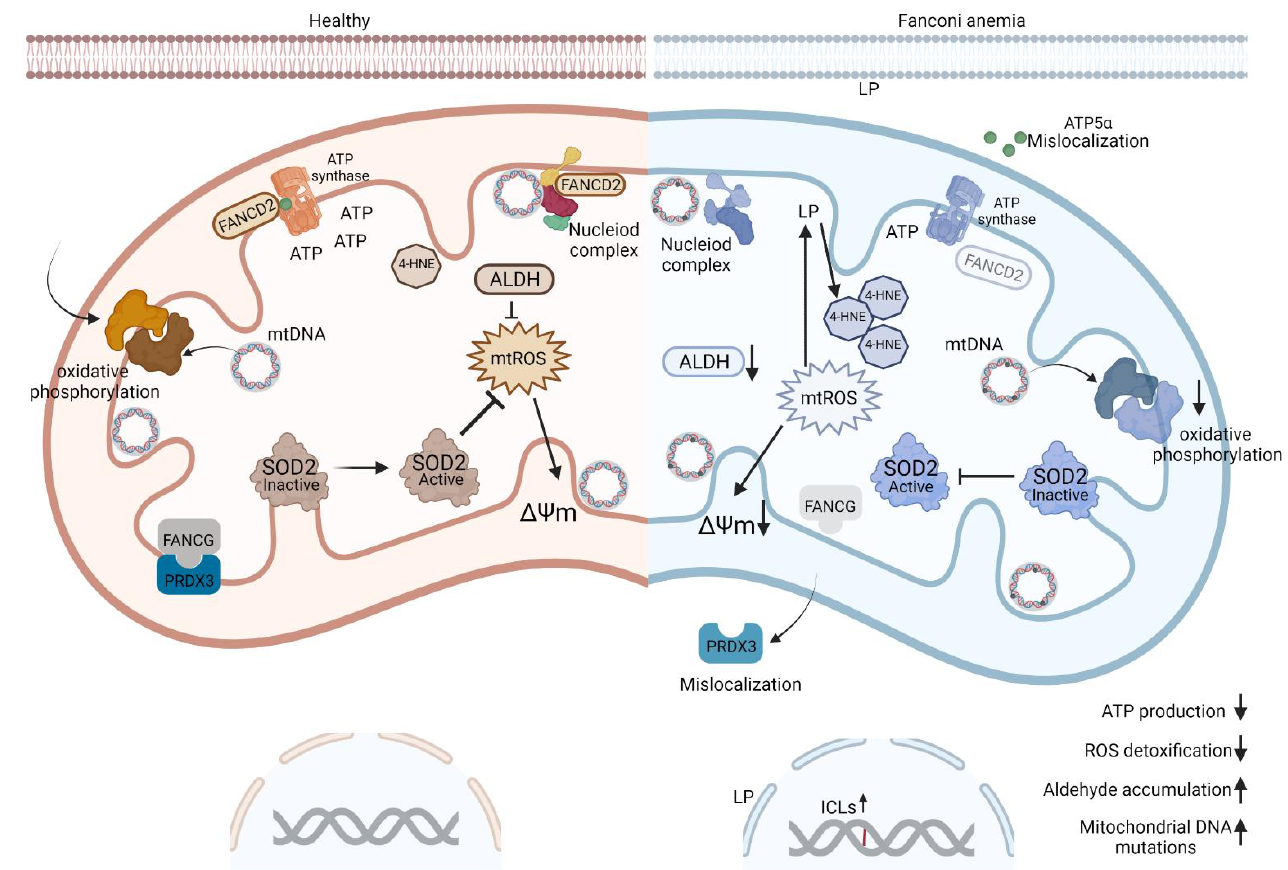
Figure 2. Schematic of Fanconi Anemia (FA) protein function in healthy (brown, left) versus FA- deficient (blue, right) mitochondria. Mitochondrial ROS (mtROS) are continuously generated by metabolic and inflammatory reactions. Mitochondrial DNA (mtDNA) primarily encodes mitochon- drial proteins, including those involved in respiration and oxidative phosphorylation. Increased mtROS production leads to increased mtDNA mutations and lipid peroxidation (LP). FANCD2 localizes, in part, to mitochondria in a process facilitated by the ATPase Family AAA Domain-Containing Protein 3A (ATAD3) member (yellow barbell) of the mitochondrial nucleoid complex, which is essential for transcription and translation of mitochondrial proteins; FANCD2 deficiency destabi- lizes the nucleoid comp lex. FANCD2 also interacts with the ATP5α subunit (green dots) of ATP synthase. FAND2 knockdown results in mislocalization of ATP5α, and diminishes ATP production. In contrast, FANCG binds to PRDX3 on the inner mitochondrial membrane, and FANCG-mutant fibroblasts harbor mislocalized PRDX3, which results in reactive oxygen species (ROS) accumulation. Similar to peroxidase peroxiredoxin-3 (PRDX3), superoxide dismutase 2 (SOD2) has antioxidant activities in the mitochondria and is activated in the presence of ROS. FANCA-deficient cells have shown a decrease in SOD2 activity [105]. Uncontrolled accumulation of ROS results in decreased mitochondrial transmembrane potential (Δ Ѱ m) and thus ATP synthesis. Schematic of FA protein function in healthy (brown, left) versus FA-deficient (blue, right) mitochondria. Available online: https://biorender.com/illustrations (accessed on 11 March 2022).